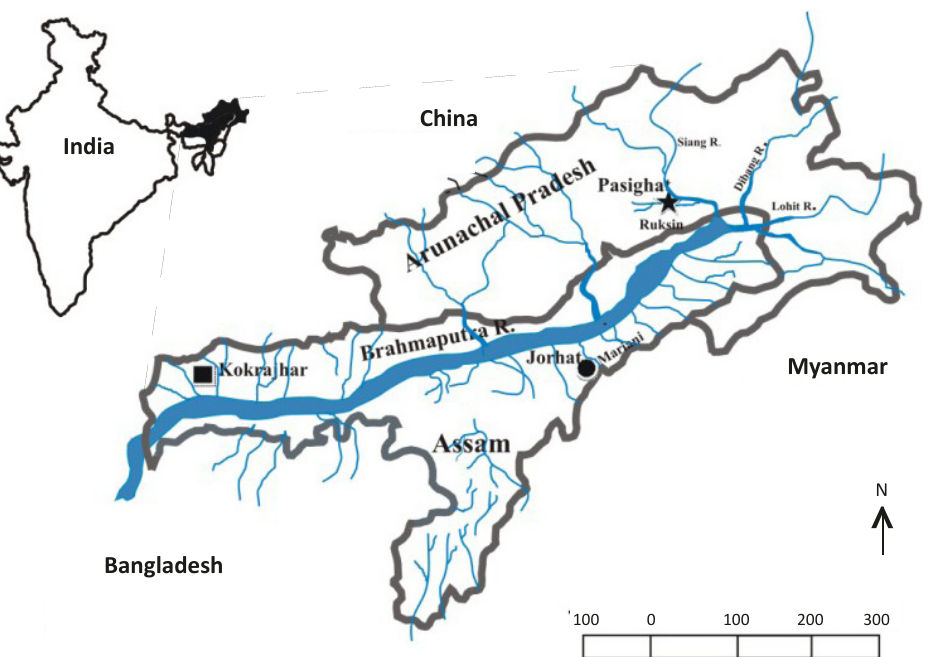
Figure 2. The distribution of Batasio merianiensis indicated by star (present collection), circle (Chaudhuri 1913) and square (Ng 2009).